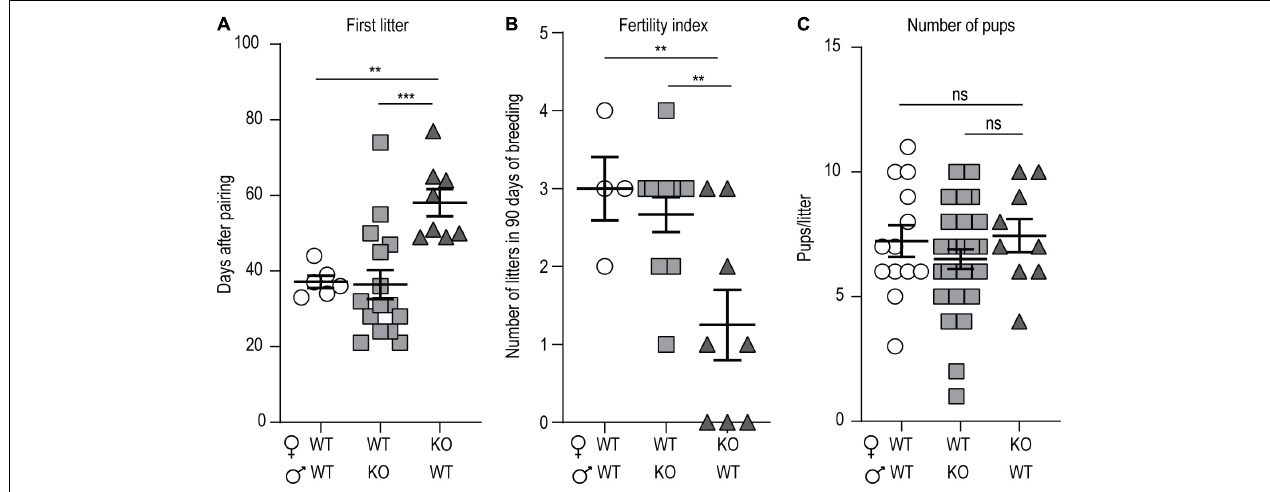
FIGURE 1 | p140Cap KO female mice are hypofertile. (A) Number of days required to produce the first litter. n = 7 matings WT × WT; 15 matings WT female × p140Cap KO male; 8 matings 140Cap KO female × WT male. Kruskal-Wallis test, P = 0.002; post hoc Dunn’s test, P ( WT × WT ) = 0.02, P ( WT female × p 140 Cap KO male ) < 0.001. (B) Total number of litters per mating over 90 days. n = 4 matings WT × WT; 12 matings WT female × p140Cap KO male; 8 matings 140Cap KO female × WT males. Kruskal-Wallis test, P = 0.03; post hoc Dunn’s test, P ( WT × WT ) = 0.02, P ( WT female × p 140 Cap KO male ) = 0.02. (C) Number of pups per litter. n = 12 litters WT × WT; 24 litters WT female × p140Cap KO male; 9 litters 140Cap KO female × WT males. Kruskal-Wallis test, P = 0.44. Data are represented as means ± SEM. ** = P < 0.01, *** = P < 0.001, ns = not